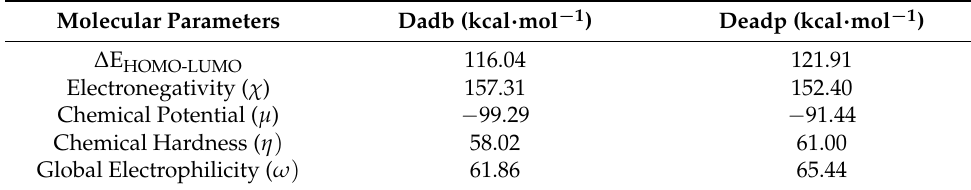
Table 2. Reactivity index of DADB and DEADP